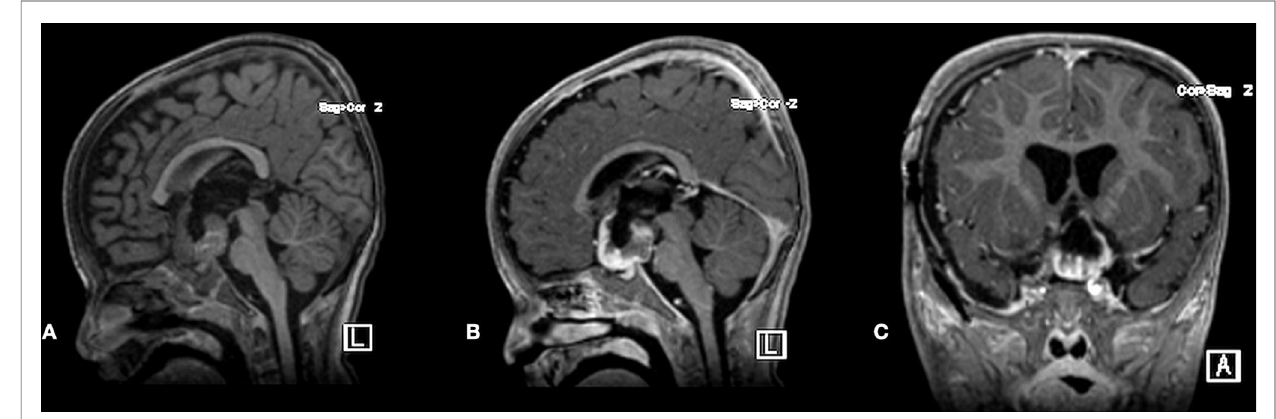
FIGURE 8 | Postoperative plain sagittal T1-WI MRI scan and post-contrast T1-WI sagittal and coronal MRI scans demonstrated adequate decompression and stable residual tumor at